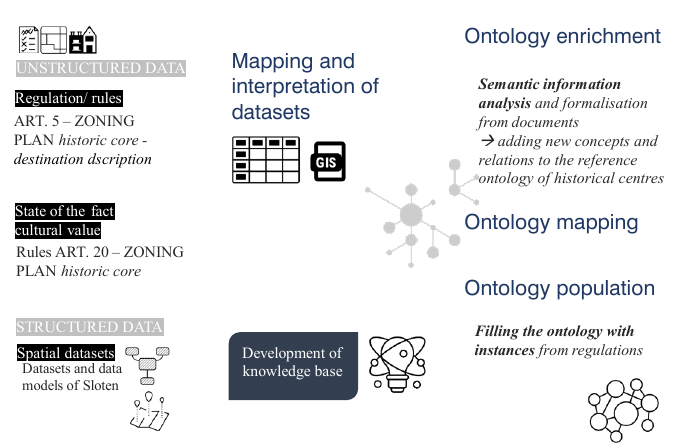
Figure 4. Workflow of the